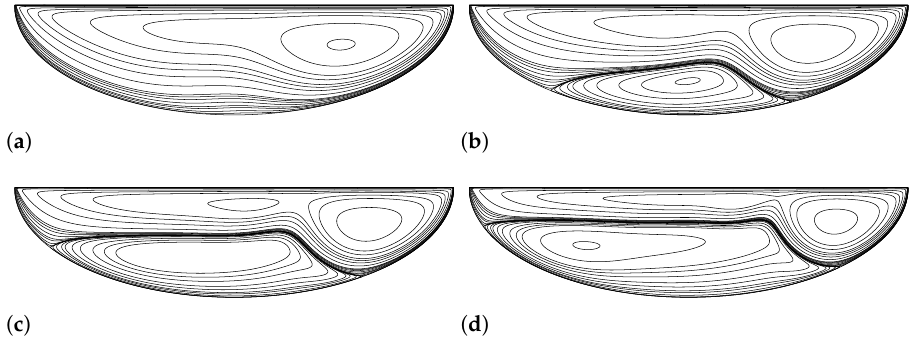
Figure 5. The evolution of the 1st solution of driven semi-elliptical cavity flow until Re = 5000 for D = 0.5 aspect ratio. ( a ) Re = 1000 (1st solution). ( b ) Re = 2000 (1st solution). ( c ) Re = 3000 (1st solution). ( d ) Re = 5000 (1st